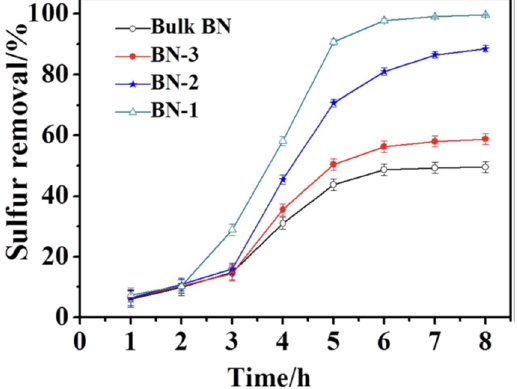
Figure 11. Effect of exfoliation cycles on sulfur removal [92].